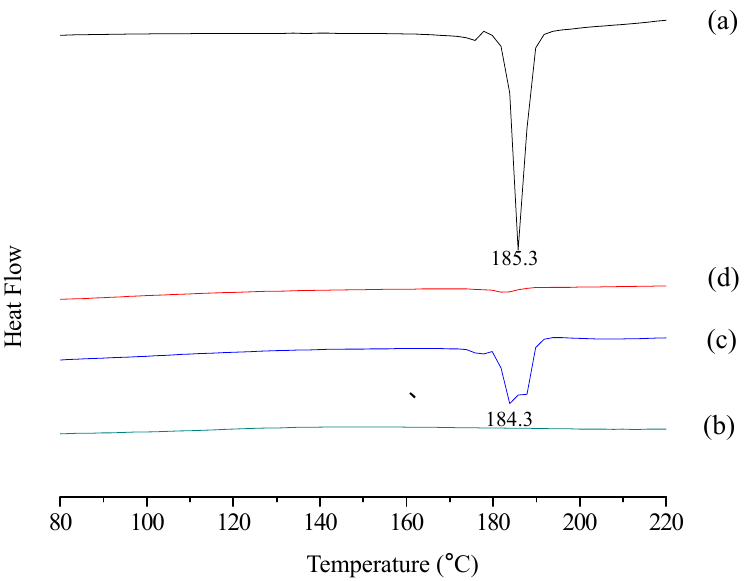
Figure 3. DSC thermograms of curcumin ( a ); cyclodextrin polymer ( b ); curcumin and cyclodextrin polymer physical mixture ( c ); curcumin/cyclodextrin polymer inclusion complex ( d ).